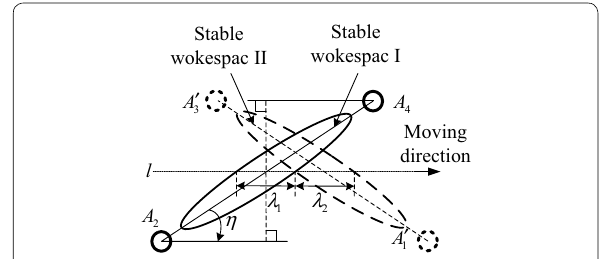
Figure 17 Two stable workspaces of two adjacent equivalent mechanisms in step forward stages